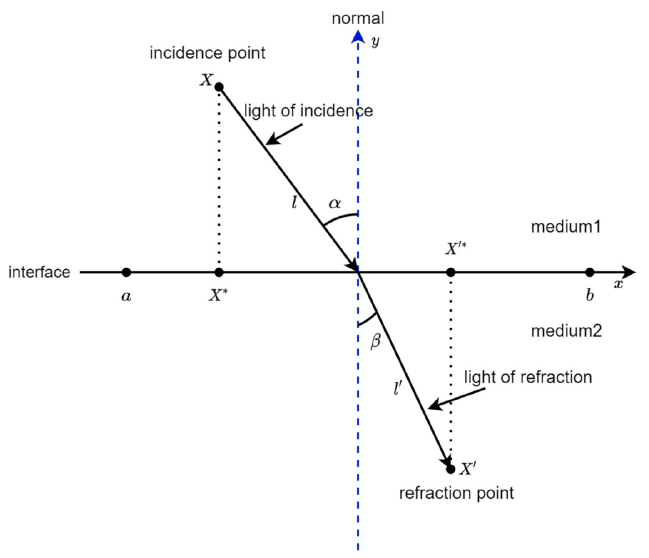
Figure 5. One-dimensional spatial refraction learning process for the current global optima X ∗